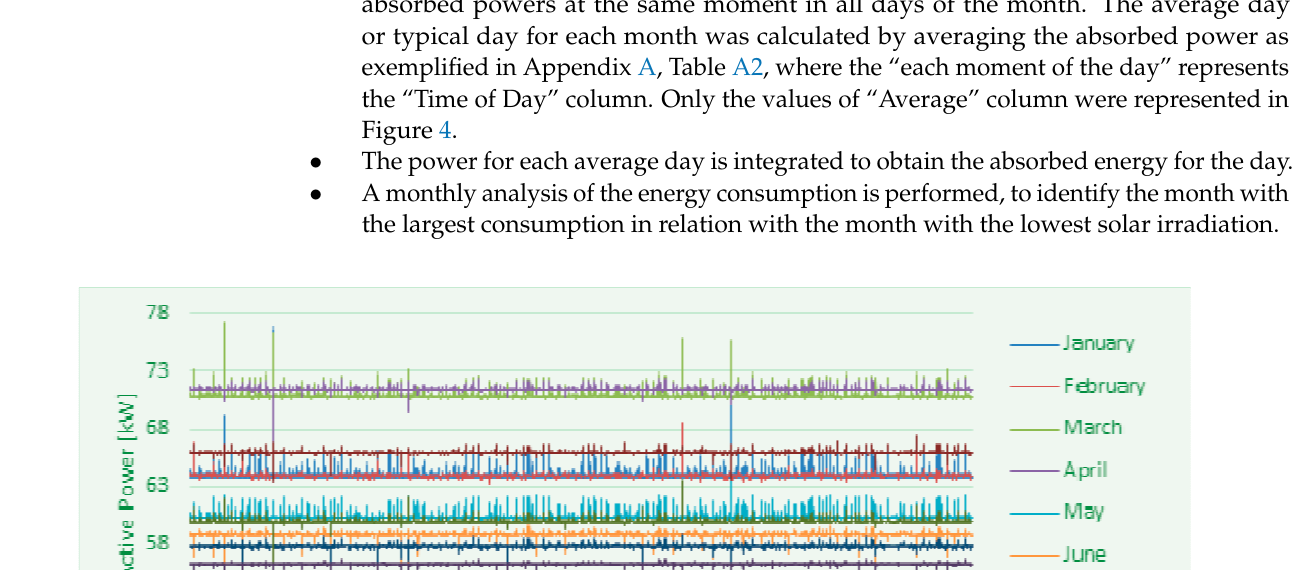
Figure 3. Flowchart of average day for consumed active power.